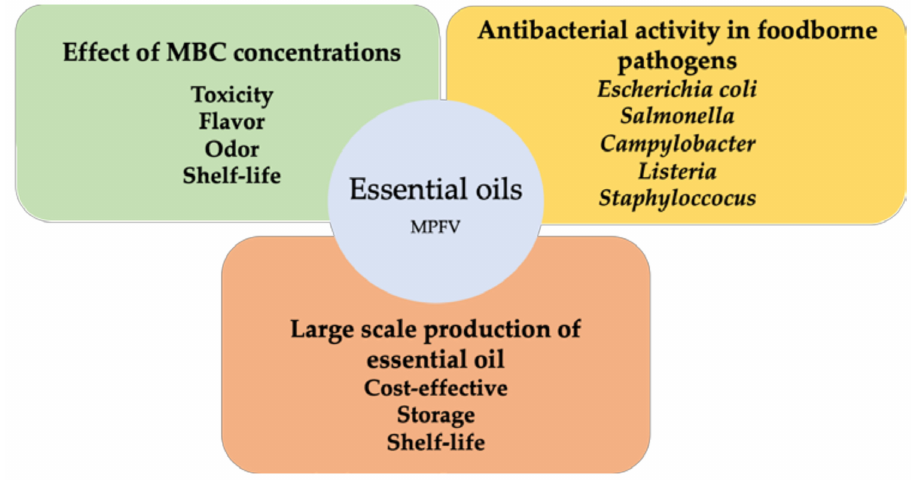
Figure 2. Factors affecting the practicality of essential oil antibacterial activity of minimally processed foods in the food